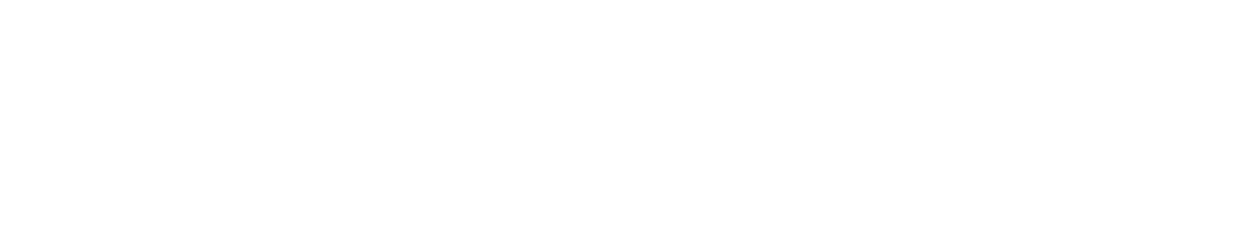
Frontiers in Pharmacology |